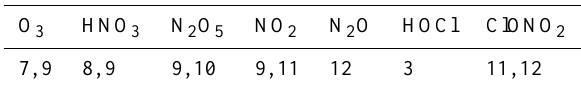
Table 1. Baseline versions for spectra version V3O of the employed MIPAS